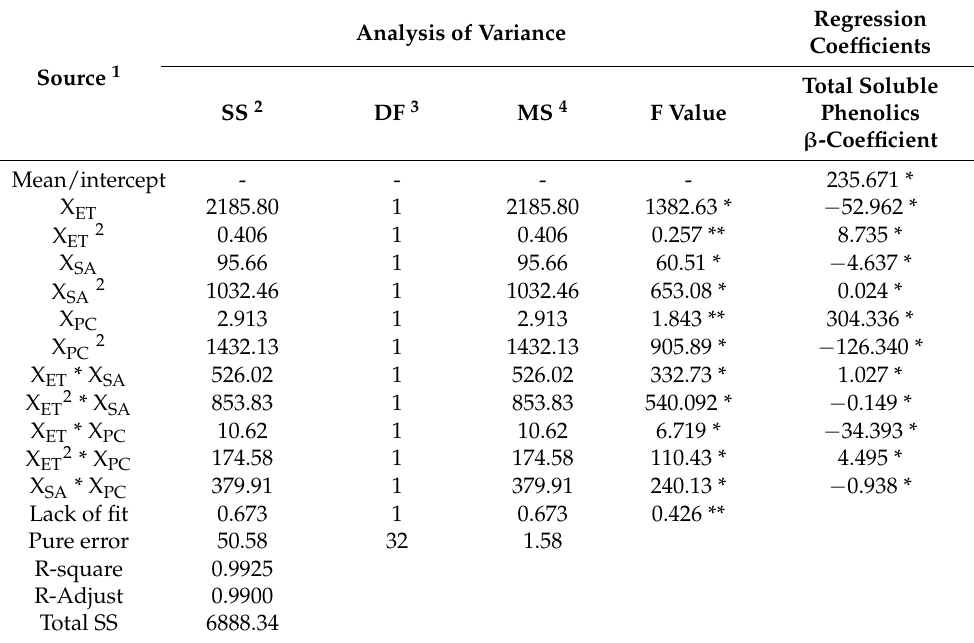
1 Extraction time (X ET ), Sonication amplitude (X SA ), and Pulse cycle (X PC ). freedom. 4 MS, means square. * Significant ( p < 0.05), ** non-significant ( p >